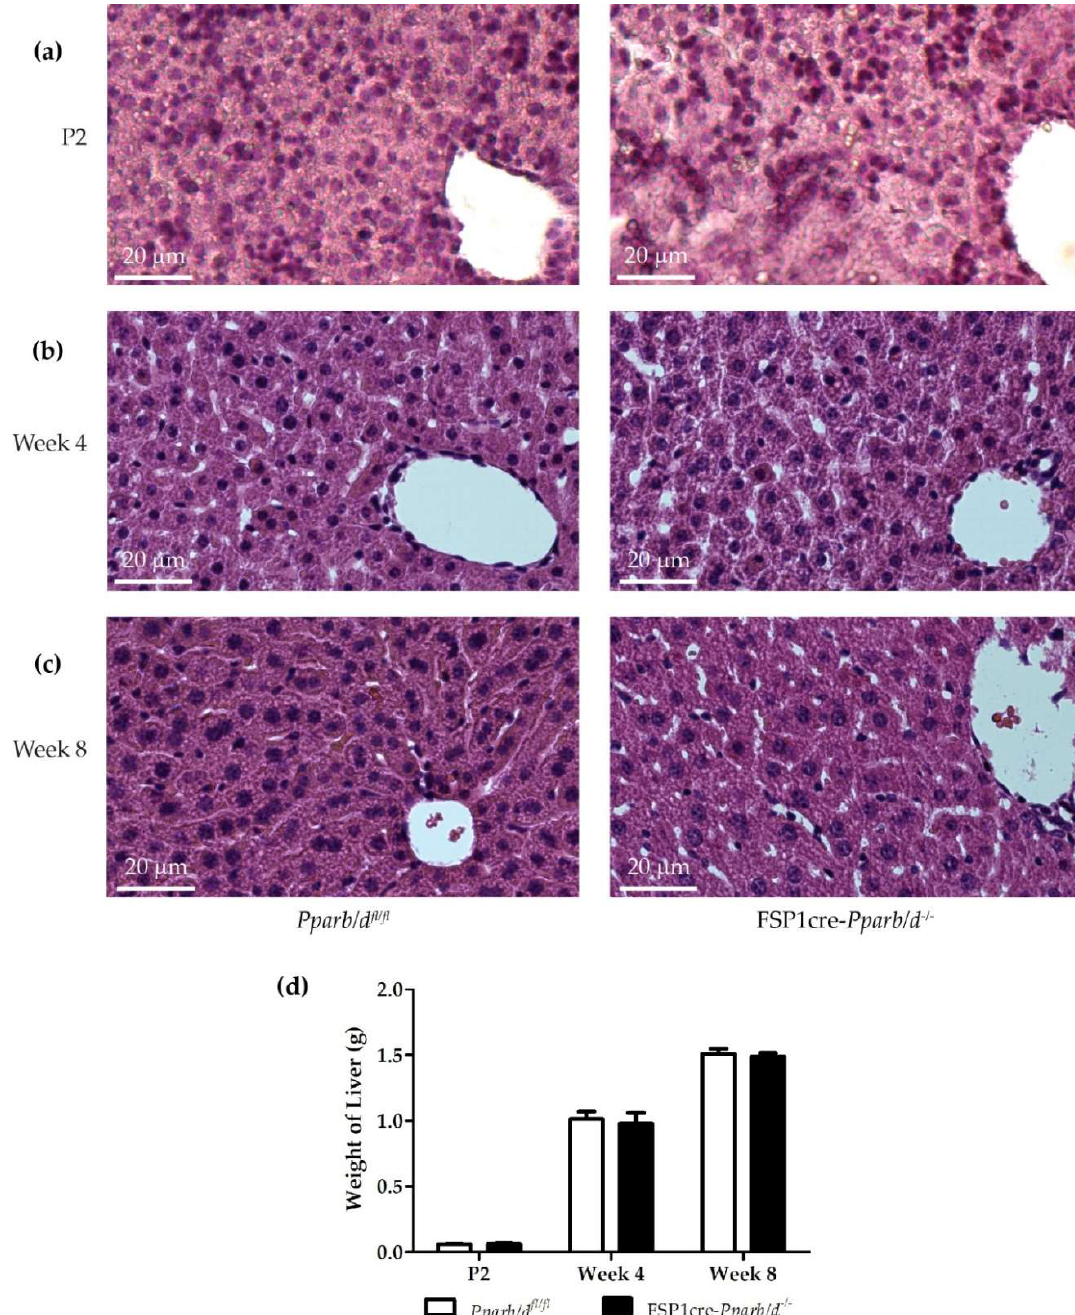
Figure 3. H&E staining of liver sections and comparison of the liver weight in Pparb / d fl / fl and FSP1cre- Pparb / d − / − mice at three age points. ( a ) Postnatal day 2 (P2) livers. ( b ) Week 4 of age livers. ( c ) Week 8 of age livers. ( d ) Weight of livers of the two genotypes at each age is shown. Data are shown as mean ± s.e.m, n = 10–14 biological replicates per group.